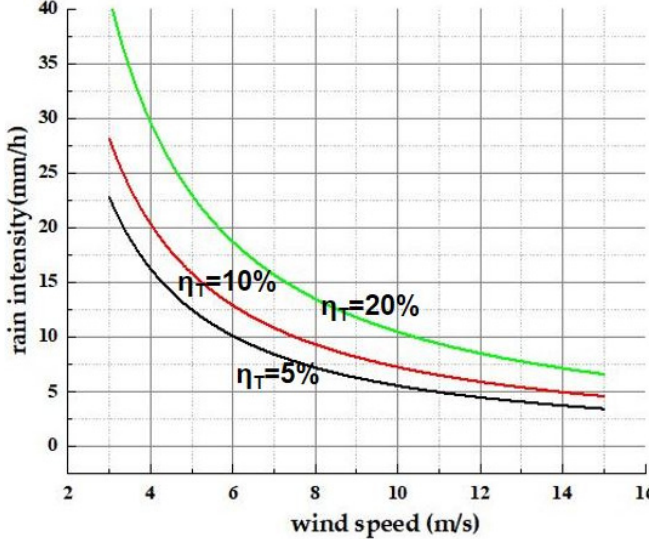
Figure 16. η T-fitting curve.